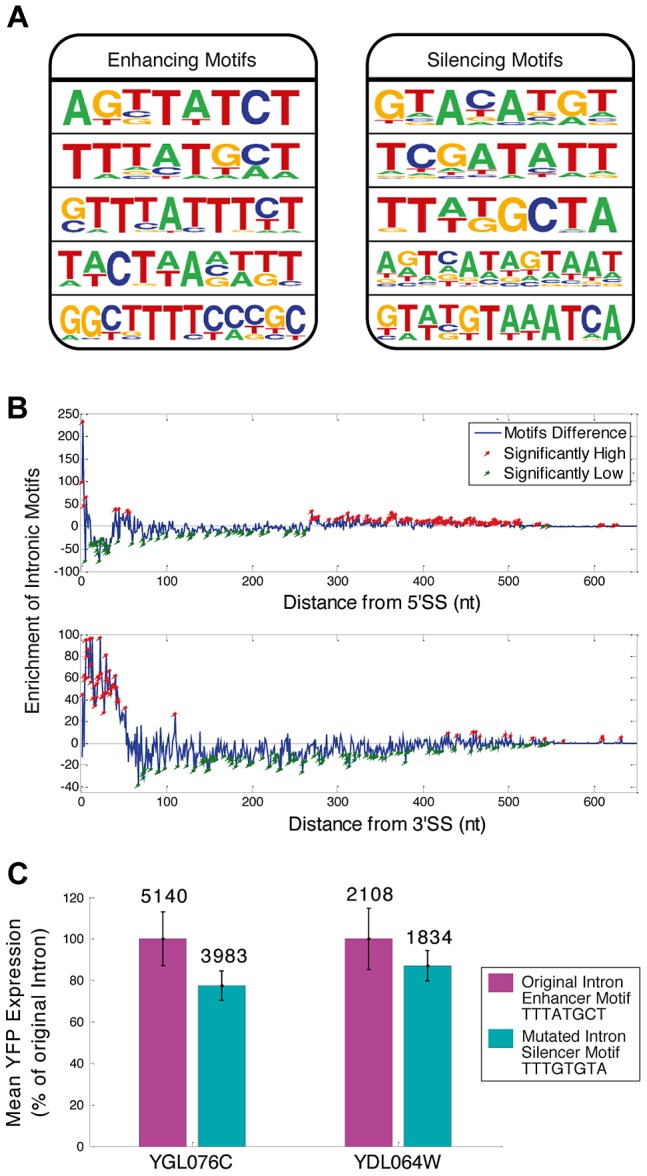
Sequence motifs function “out of context”.A) Motifs associated with splicing efficiency were revealed by comparing intron sequences of high and low expressing YiFP strains. Examples of five enhancers (enrichment p<3.4e-4) and silencers (p<4e-4) are shown. B) The novel motifs were enriched in proximity to intron ends. Enrichment of motifs in introns compared to a randomized/permutated version of the motifs that maintain their properties (blue line, Materials and methods) is presented in respect to distance from 5′- or 3′ Splice Site (SS) (top and bottom, respectively). Positions significantly enriched or deprived of motifs are marked in red and green, respectively. C) Reporter YFP expression is decreased upon exchange of an enhancer to a silencer motif in two independent intron strains. Mean YFP expression was calculated for triplicates of the two intron library strains (YGL076C- p = 0.02, and YDL064W- p = 0.2). Average expression of each mutated motif strain is shown in comparison to that of the natural intron harboring YiFP strain (100%). Numbers inset in bars indicate the mean YFP expression level (non-relative).